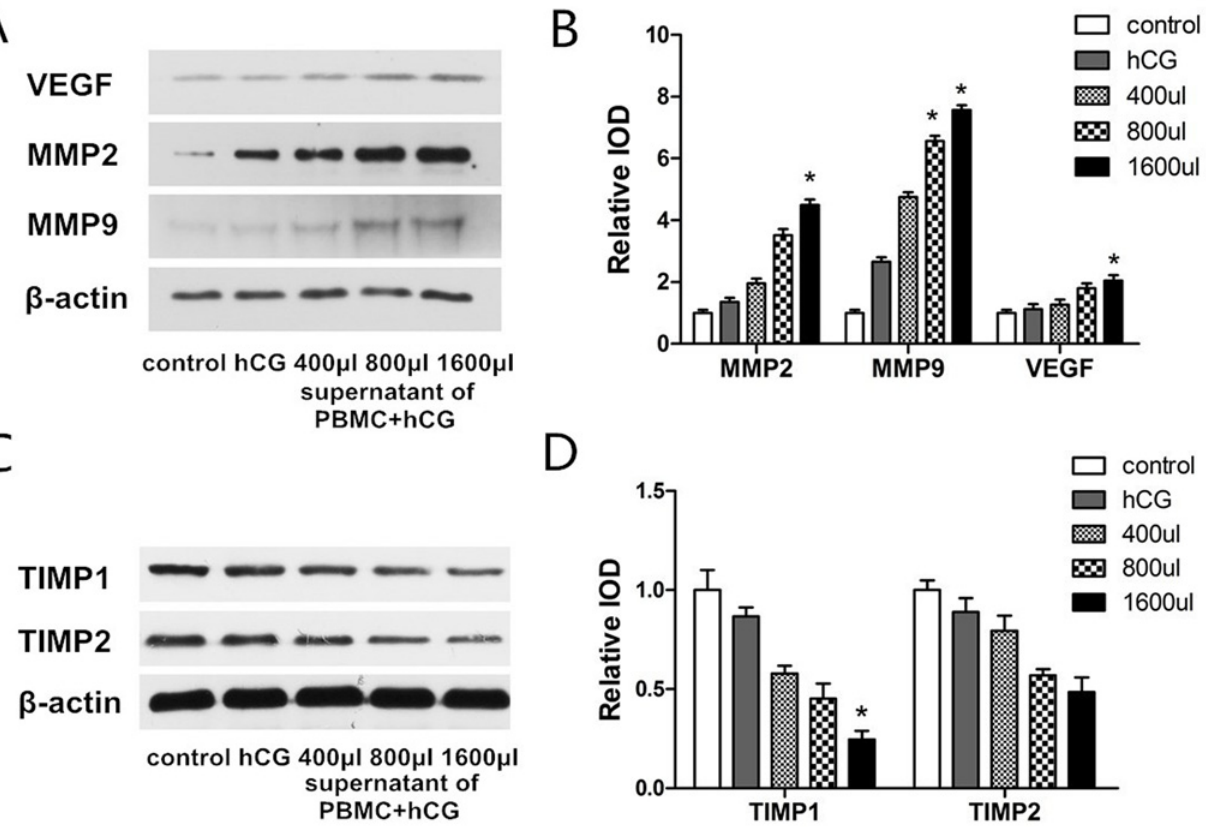
Fig 3. Effect of peripheral blood mononuclear cells (PBMC) activated by human chorionic gonadotropin (hCG) on the protein expression of matrix metalloproteinase (MMP)-2, MMP-9, vascular endothelial growth factor (VEGF), and tissue inhibitor of metalloproteinase (TIMP)1 and TIMP-2 in JAR cells by western blotting assays. (A) Protein expression of MMP-2, MMP-9, VEGF, TIMP-1, and TIMP-2 in control JAR cells or those cultured in hCG, 400, 800, or 1600 μ L culture medium supernatant of PBMC with hCG. (B) The intensity of protein expressions of JAR cells compared to control cells using western blot analysis. Data are expressed as mean ± standard error of the mean of triplicate experiments. * , P < 0.05 compared with the control and hCG groups.